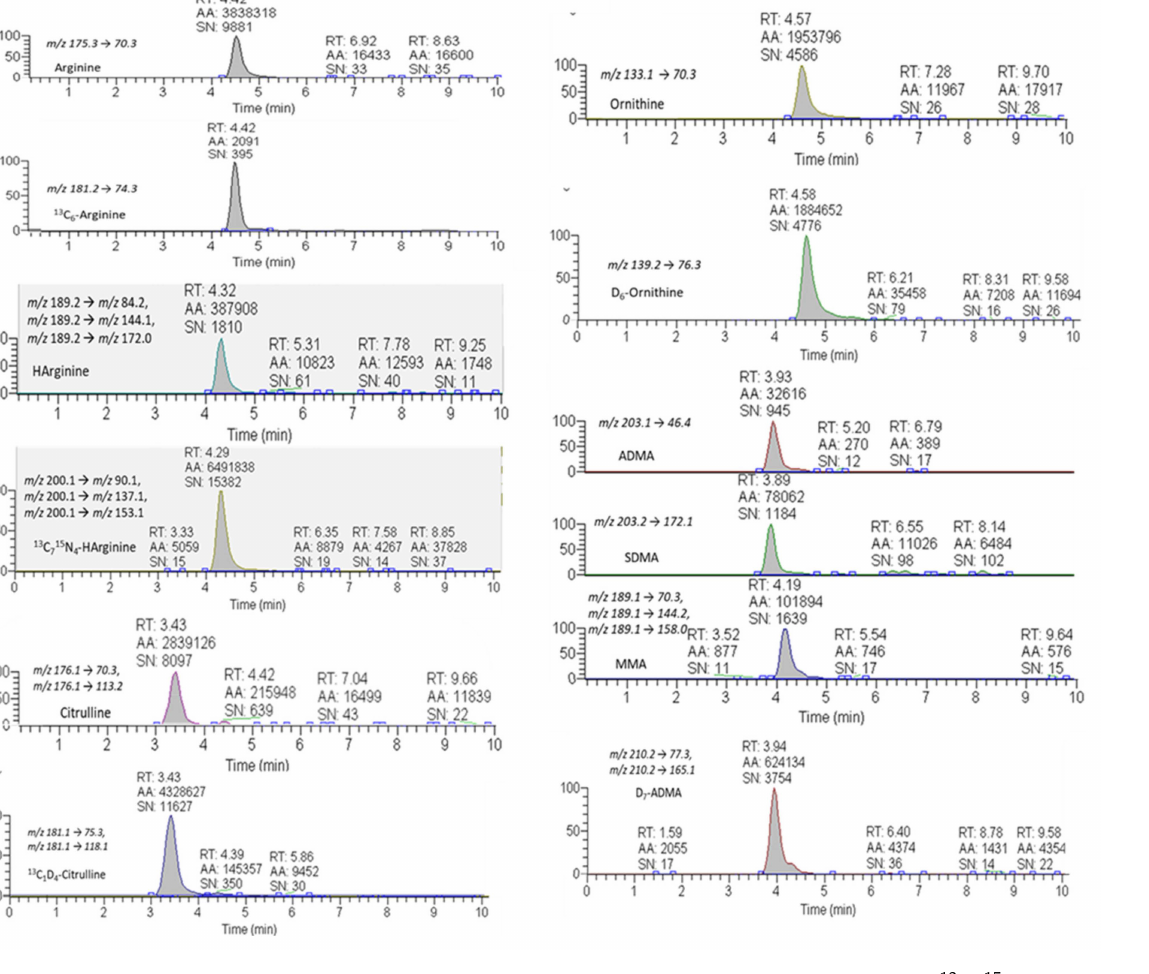
Figure 2. Representative chromatograms of HArg and its internal standard ( 13 C 7 15 N 4 -HArg), together with all the other metabolites involved in the Arg/NO metabolic pathway. The figure depicts the analysis of the pooled plasma (PP) added with a standard mix at a concentration of 2.5 µ M. The 8-point calibrator concentrations (0.156–20 µ M) of the standard (HArg) prepared in solvent plotted against the ratio of the analyte/internal standard areas for five